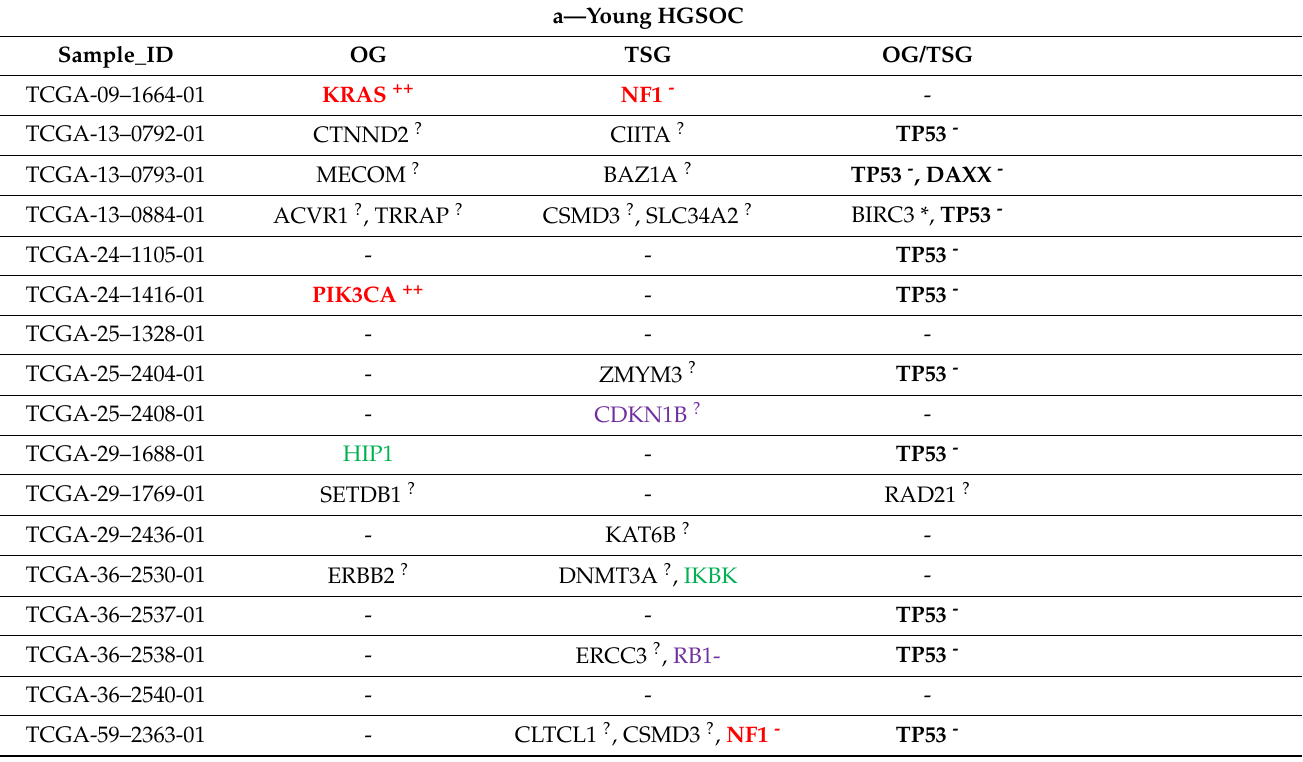
Table 3. Oncogenes and TSGs altered on samples of HGSOC and TNBC from young and elderly patients and their mutational